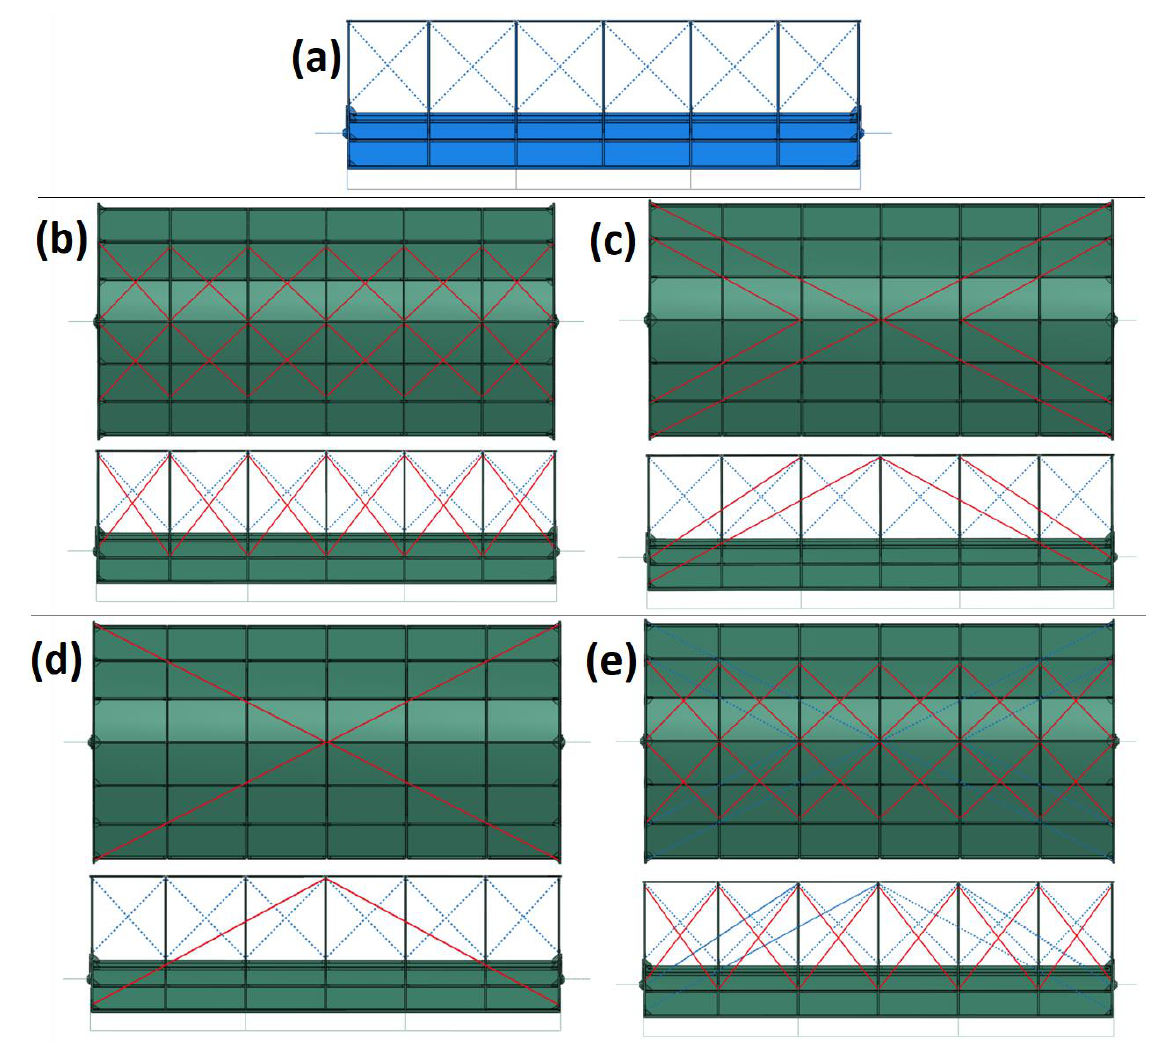
Figure 18. Configuration 0 with the guy-wires adopted in the original set-up ( a ), configuration A ( b ), configuration B ( c ), configuration B1 ( d ), configuration C ( e ). Table 9. Comparison of all the